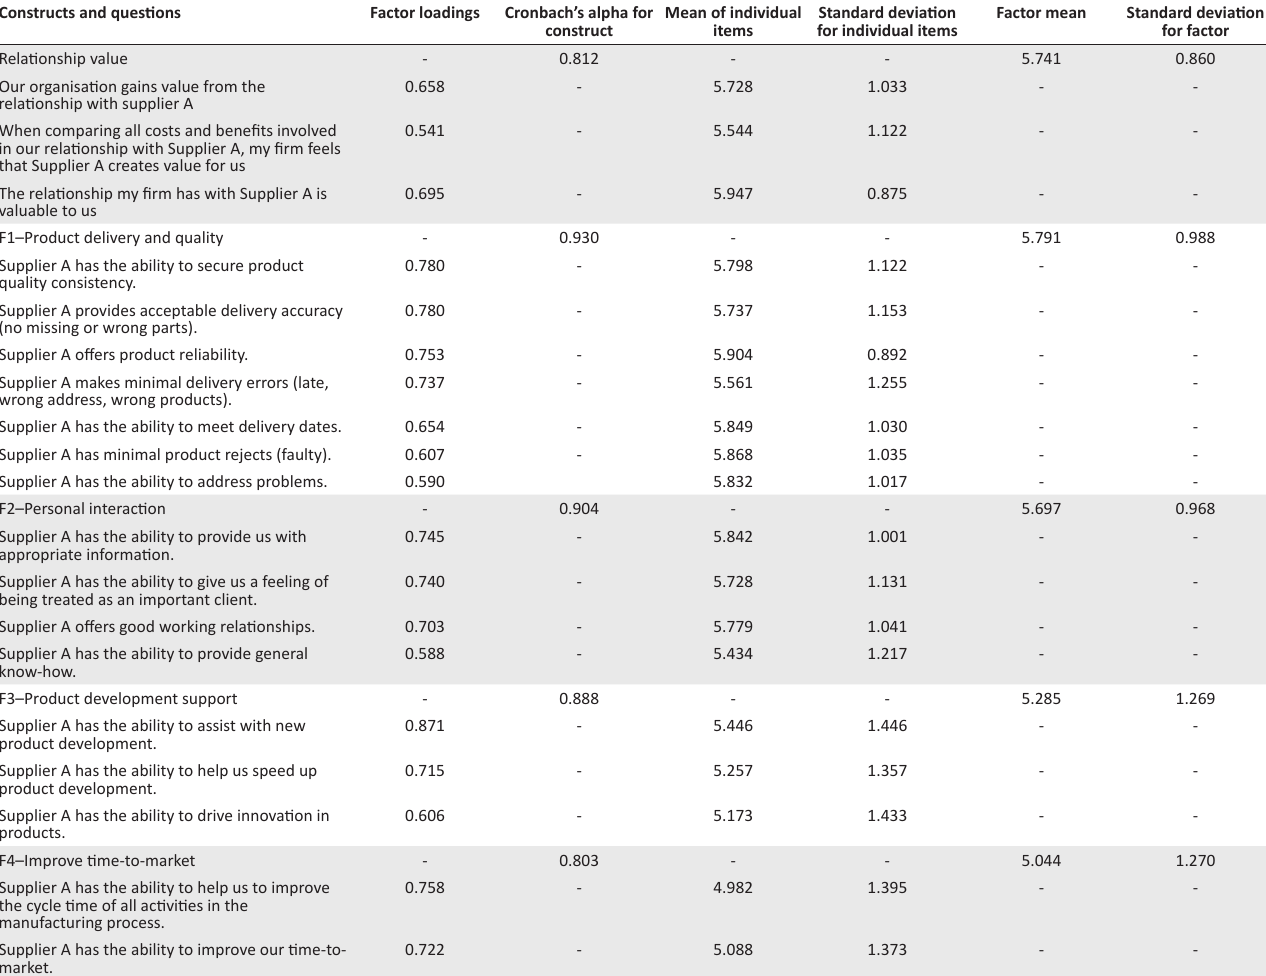
TABLE 1: Factors. Constructs and